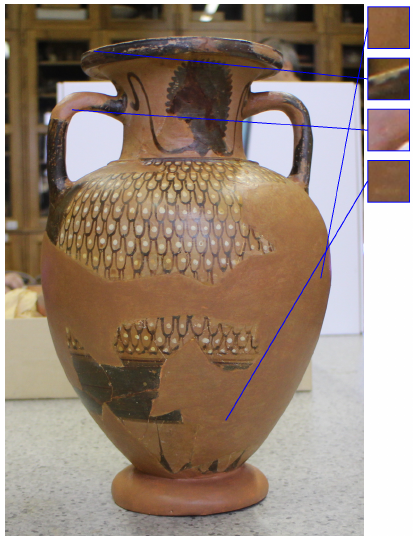
Figure 4. Feature point